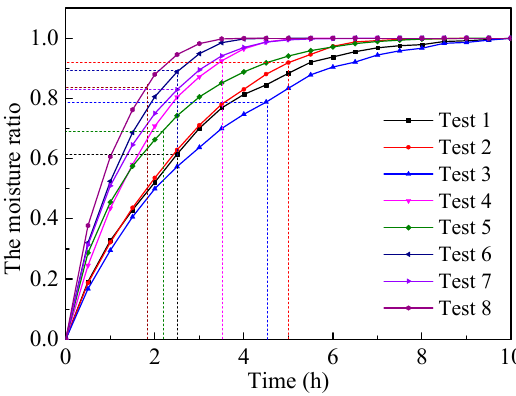
Figure 11. Variation of the total moisture ratio of solid desiccant with time.